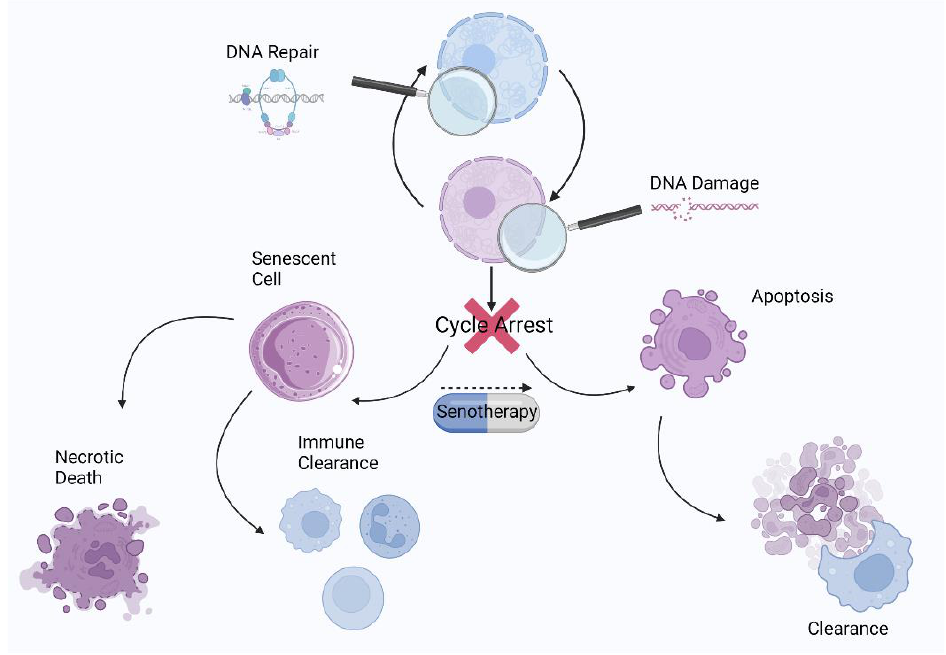
Figure 8. Schematic representation of the cell state after exit from the cell cycle and the role of senotherapy in senescence resolution.